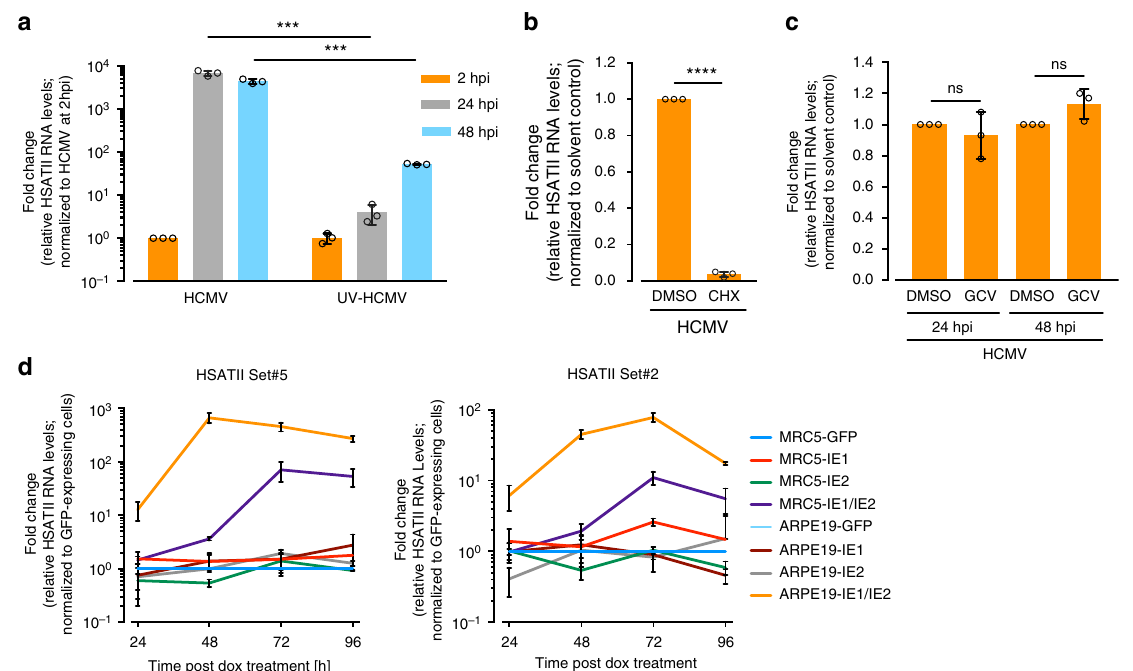
Fig. 2 Accumulation of HSATII RNA in HCMV-infected cells requires both IE1 and IE2 viral proteins. a HFFs were infected with untreated or UV-irradiated HCMV (TB40/E-GFP) at 3 TCID 50 /cell, RNA samples were collected at speci fi ed times. b HFFs were treated with CHX or DMSO, as a solvent control, 24 h before HCMV (TB40/E-GFP) infection at 1 TCID 50 /cell. RNA samples were collected at 24 hpi. c HFFs were infected with HCMV (TB40/E-GFP) at 1 TCID 50 /cell for 2 h and then media was changed for one containing GCV or DMSO as a solvent control. RNA samples were collected at 24 and 48 hpi. d Tetracycline-inducible IE1 and/or IE2 MRC-5 and ARPE-19 cells were treated with doxycycline. RNA samples were collected at indicated times. a – d RT- qPCR was performed using HSATII-speci fi c primers. GAPDH was used as an internal control. n = 3. Data are presented as a fold change mean ± SD. a – c *** P < 0.001, **** P < 0.0001 by the unpaired, two-tailed t -test with ( b , c ) or without ( a ) Welch ’ s correction. ns — not signi fi cant. Open circles